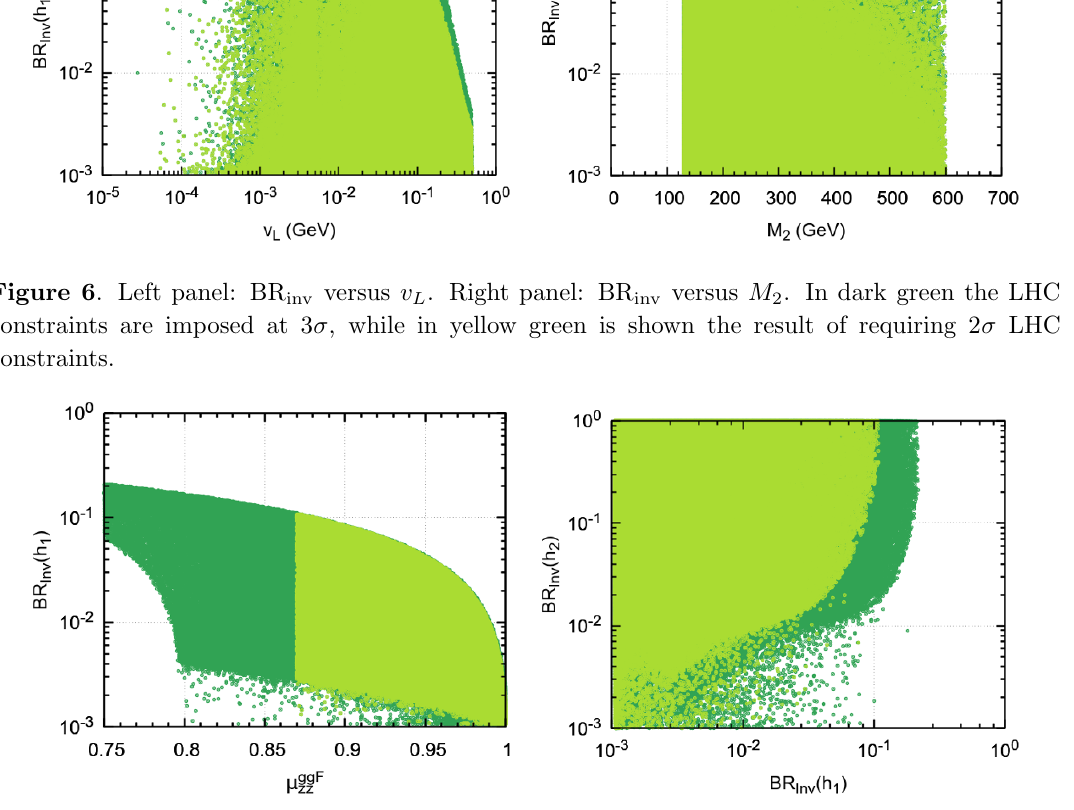
ggF Figure 7 . Left panel: BR . Right panel: BR inv ( h 2 ) versus BR inv ( h 1 ). In dark green inv versus (cid:22) zz the LHC constraints are imposed at 3 (cid:27) , while in yellow green is shown the result of requiring 2 (cid:27) LHC